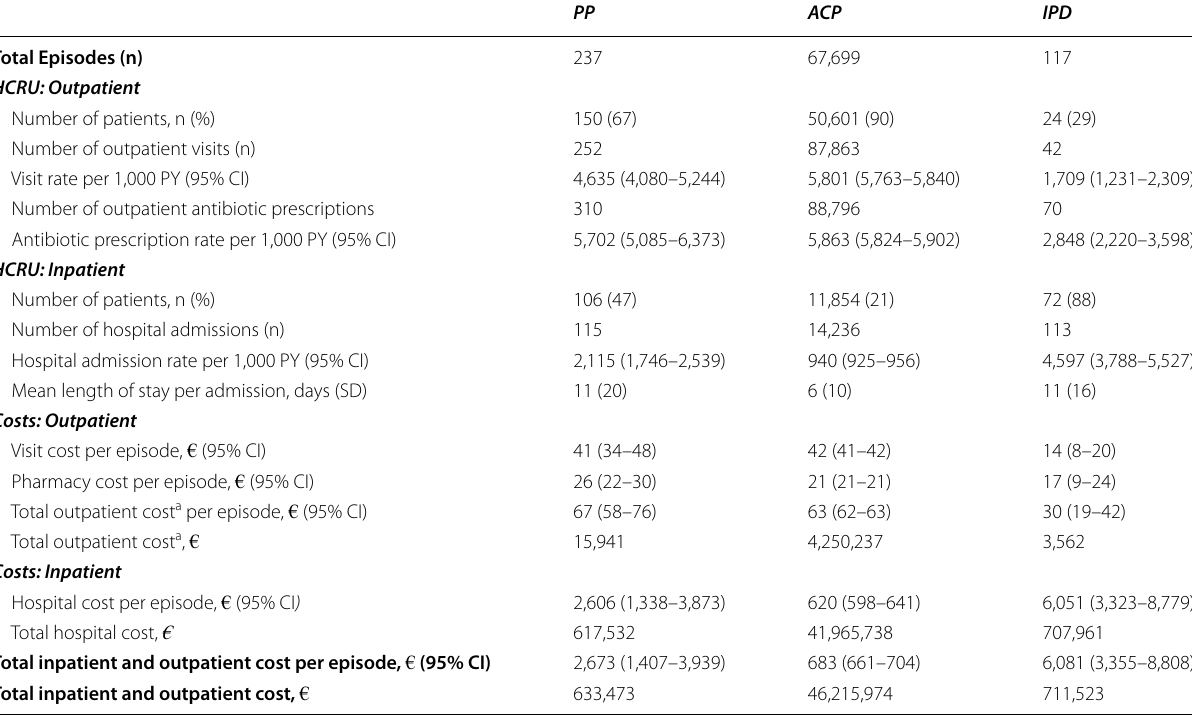
Table 2 HCRU and costs associated with pneumonia and IPD in patients with at least one episode overall during 2014 to